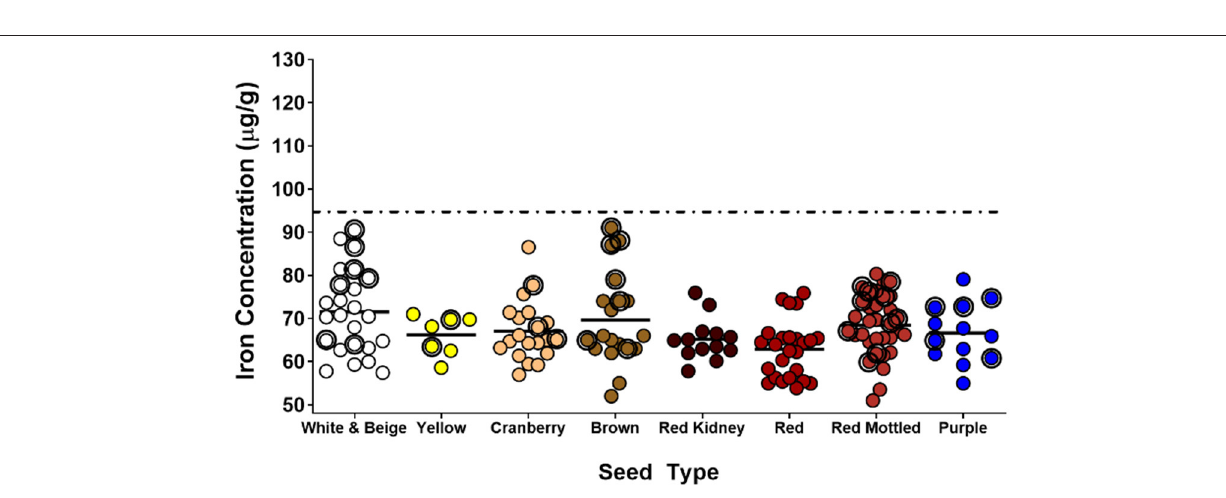
FIGURE 2 | Iron concentrations of seed collected from bean breeders of East Africa. The breeders submitted samples that were deemed representative of varieties present in marketplaces throughout countries of East Africa. Points with green circles indicate lines released as “biofortified.” Dashed line indicates the target value for biofortified beans. Adapted from Glahn et al.